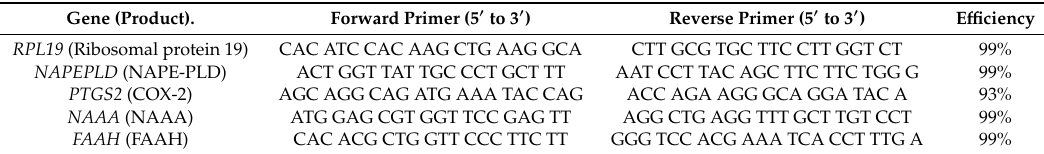
Table 2. Primer sequences for